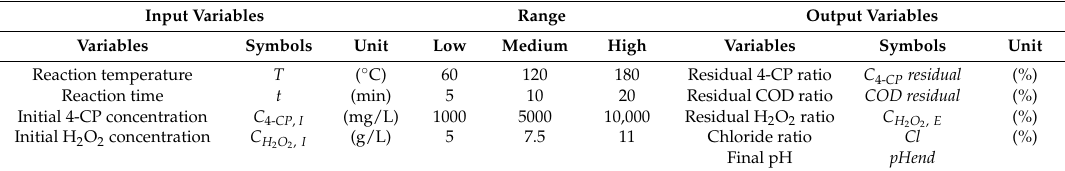
Table 1. Input and output variables of the executed Design of Experiments (DOE) and their